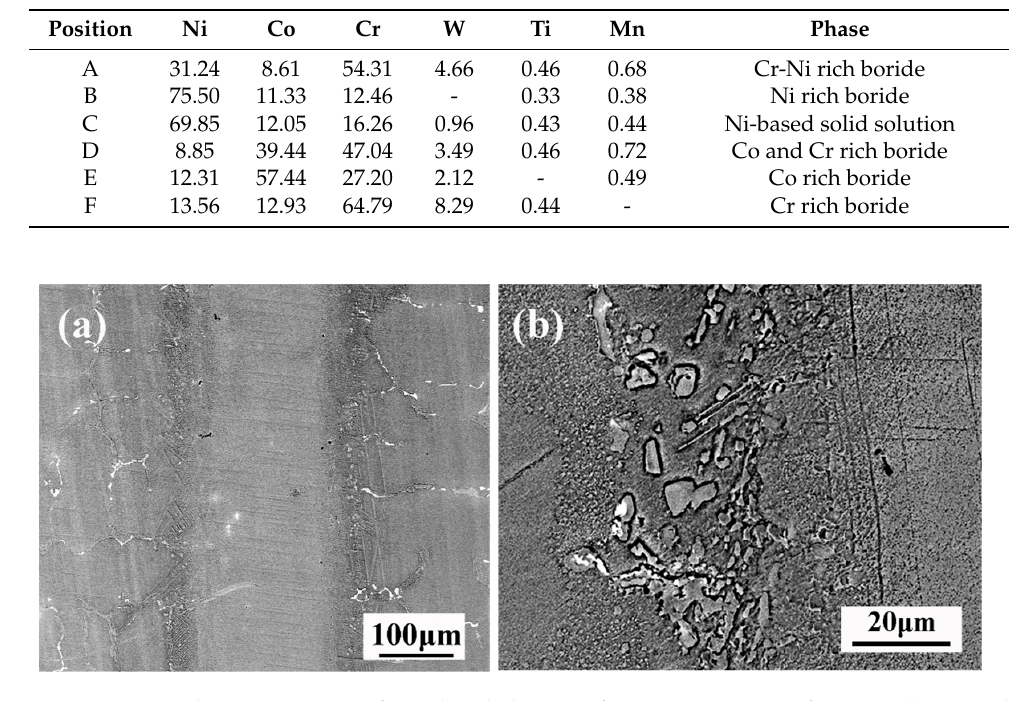
Table 3. EDS chemical analysis (at.%) of different positions in Figure 4.